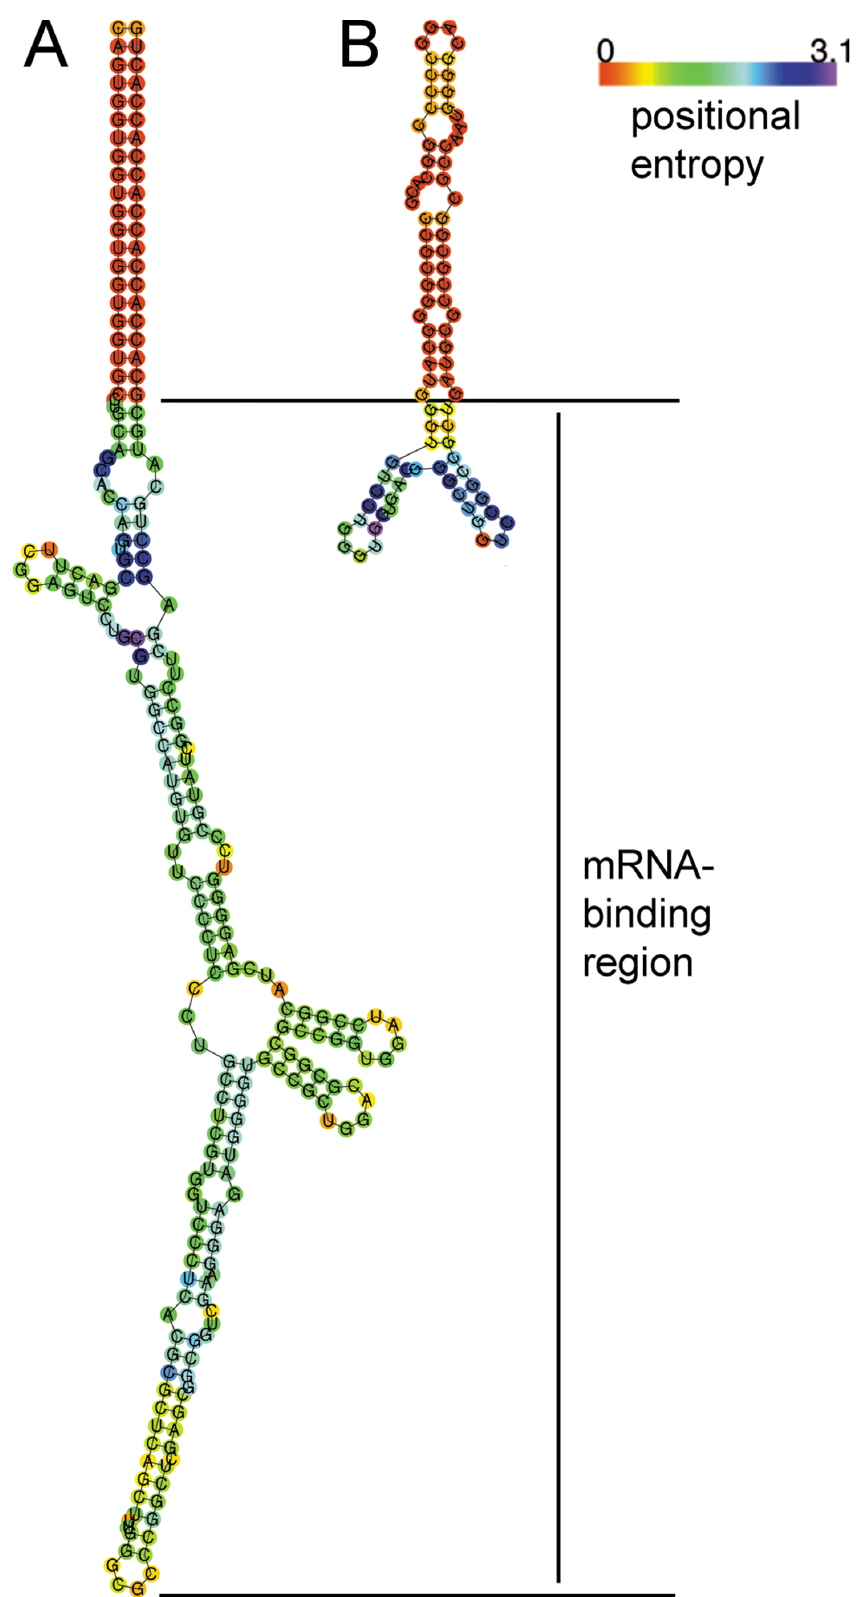
Figure 2. Predicted secondary structures of antisense RNAs. Secondary structure of (A) the paired-termini antisense act I-ORF1 asRNA ( 2 92 to + 63 bp) designed in this study for silencing of actinorhodin production, and (B) mic X, a naturally occurring trans -encoded antisense RNA from